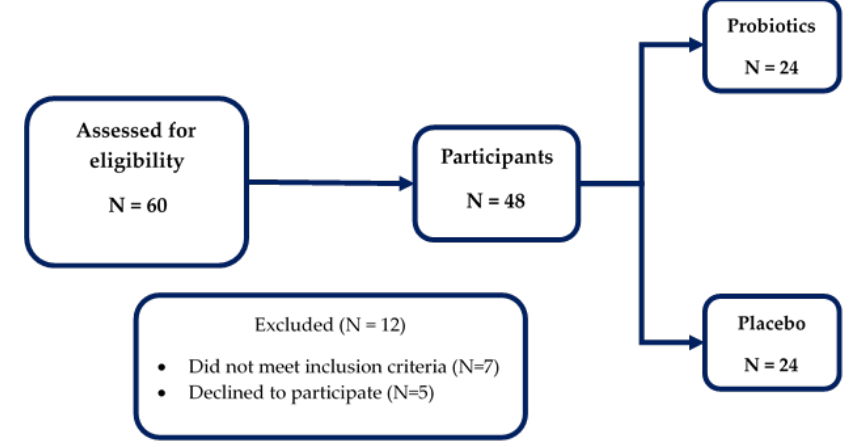
Figure 1. The enrollment and study flowchart.